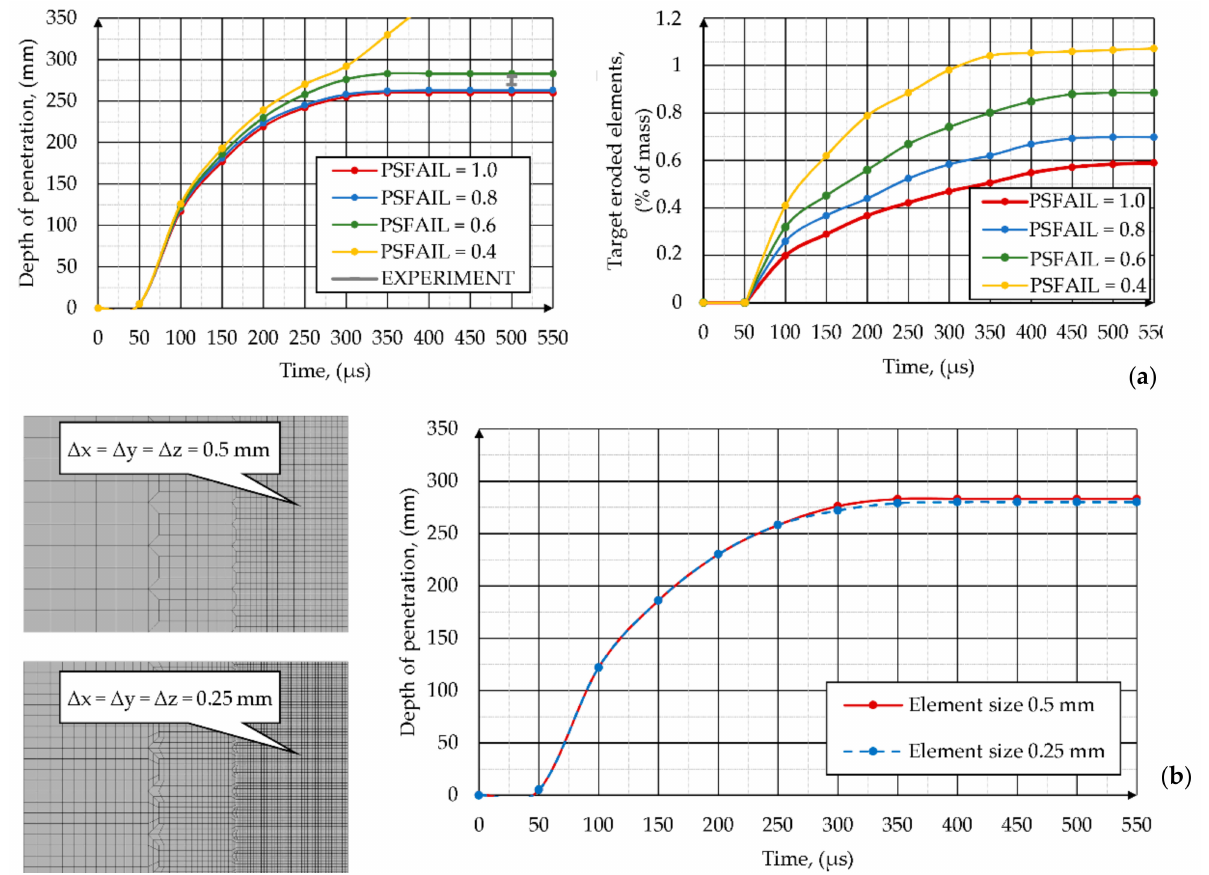
Figure 19. Influence of the value of effective plastic strain at failure in the target material model on ( a ) depth of penetration of the target and ( b ) target erosion ratio expressed in percent of mass; and influence of target mesh size on ( c ) depth of penetration of the